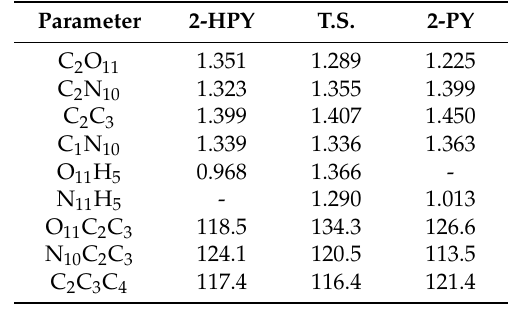
Table 1. Some selected optimized bond lengths of 2-hydroxypyridine (2-HPY) that tautomerized forming 2-Pyridone (2-PY) through the transition state (T.S.) which were obtained by using CAM-B3LYP/aug-cc-pvdz level of theory. Parameter